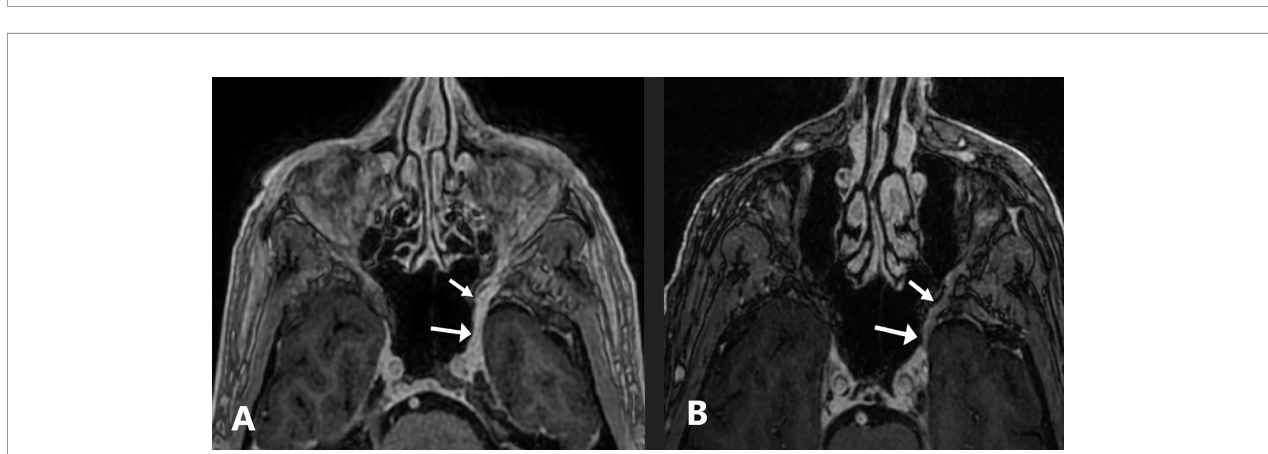
FIGURE 4 | Case 4: a 74-year-old-man with squamous cell carcinoma. (A) Axial fat-suppressed contrast-enhanced T1-weighted image shows a thickened, abnormally enhancing left V2 nerve extending from the premaxillary fat to the inferior cavernous sinus and along the left Vidian nerve (arrows). (B) Axial fat-suppressed contrast- enhanced T1-weighted image performed 6 months after permanently discontinuing pembrolizumab shows mild asymmetric enhancement of the left V2 nerve that is improved compared to pre-treatment